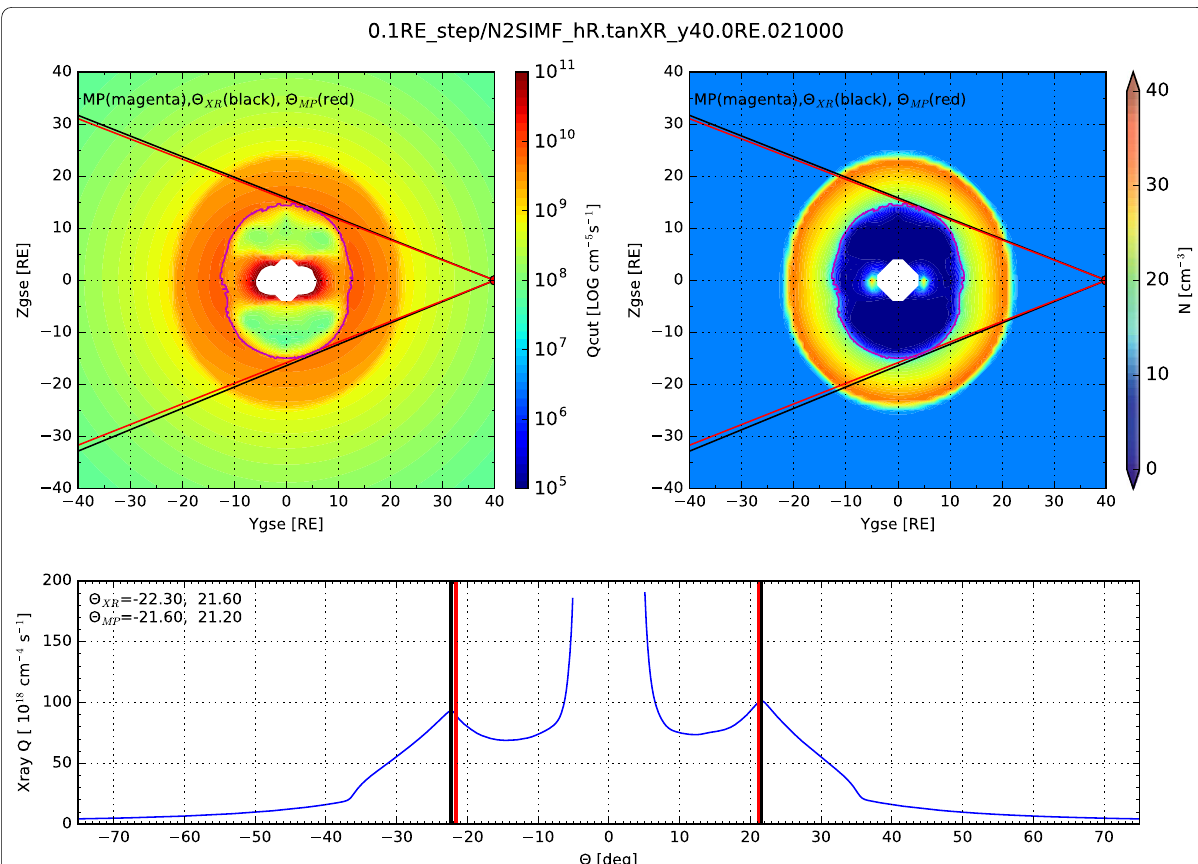
Fig. 2 Tangent direction of the magnetopause. Correspondence between the peak soft X-ray emission and the tangent to the magnetopause. The magnetopause is taken to correspond to the maximum plasmas density gradient (Figure adapted from Collier and Connor